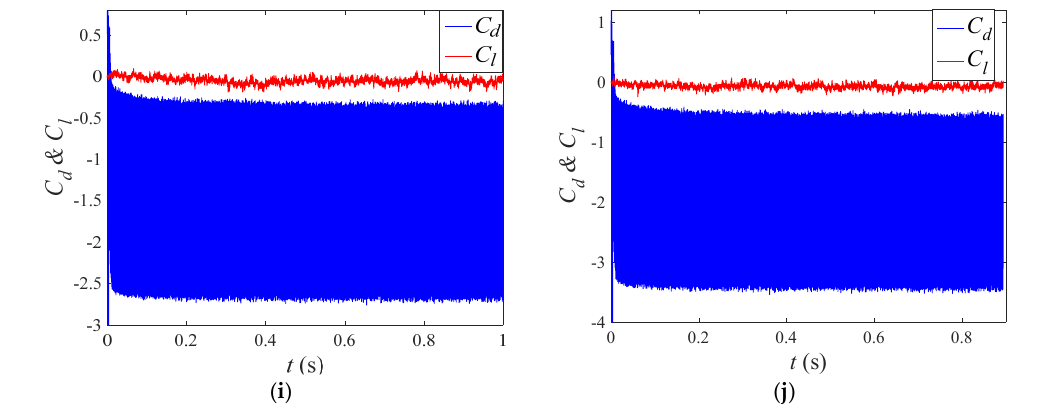
Figure 14. Lift and drag coefficient under different wave velocities. ( a ) c / U ∞ = 0.5. ( b ) c / U ∞ = 1.0. ( c ) c / U ∞ = 1.5. ( d ) c / U ∞ = 2.0. ( e ) c / U ∞ = 2.5. ( f ) c / U ∞ = 3.0. ( g ) c / U ∞ = 3.5. ( h ) c / U ∞ = 4.0. ( i ) c / U ∞ = 4.5. ( j ) c / U ∞ = 5.0.